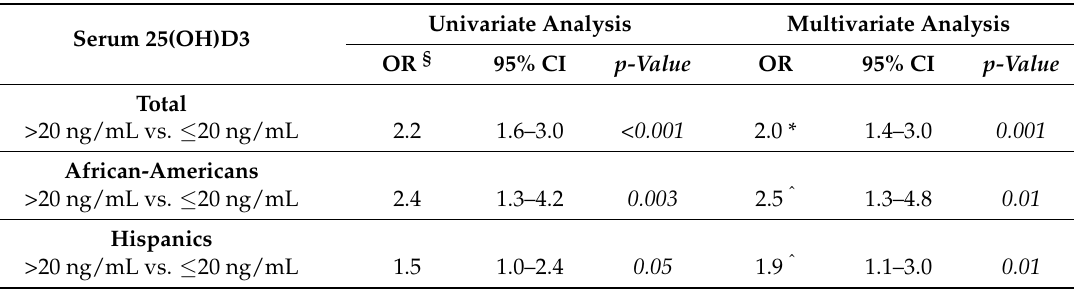
Table 4. Association of 25(OH)D3 and breast cancer.